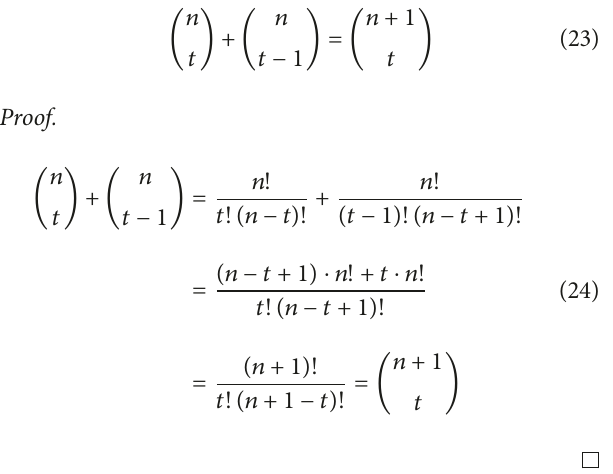
Figure 3: Structure of the binomial sequences {( 𝑛 𝑘 )} and {(